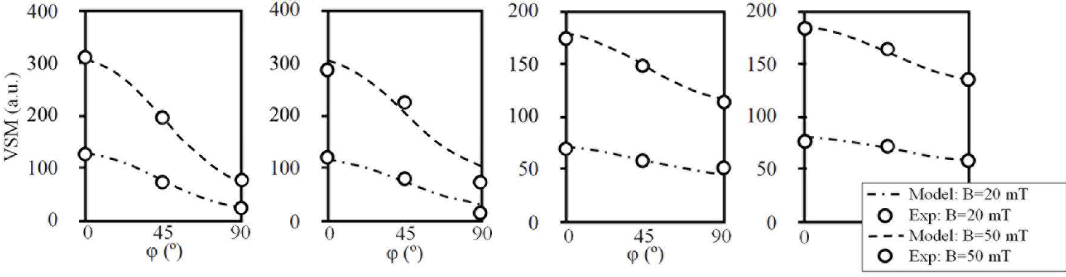
Figure 6. Plot of magnetization against azimuth angle φ.